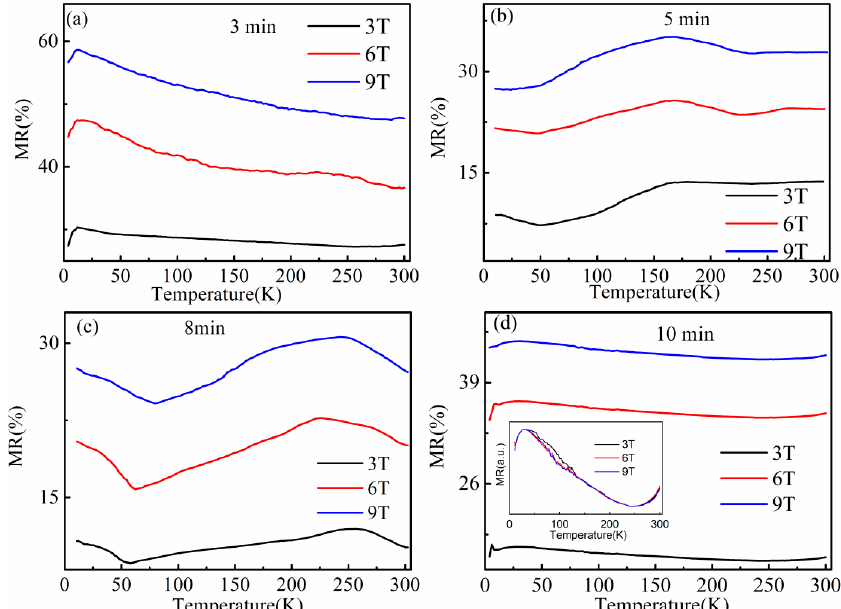
Figure 6. Temperature-dependent magnetoresistance (MR) ratio of Bi 2 Se 3 /LSMO/LAO thin films under different applied magnetic fields: ( a ) 3 min; ( b ) 5 min; ( c ) 8 min; ( d ) 10 min. Inset in ( d ): The relationship between the relative resistivity and T below 30 K.